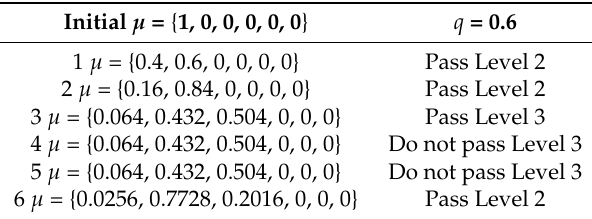
Table 3. The example of the membership change rule when q =